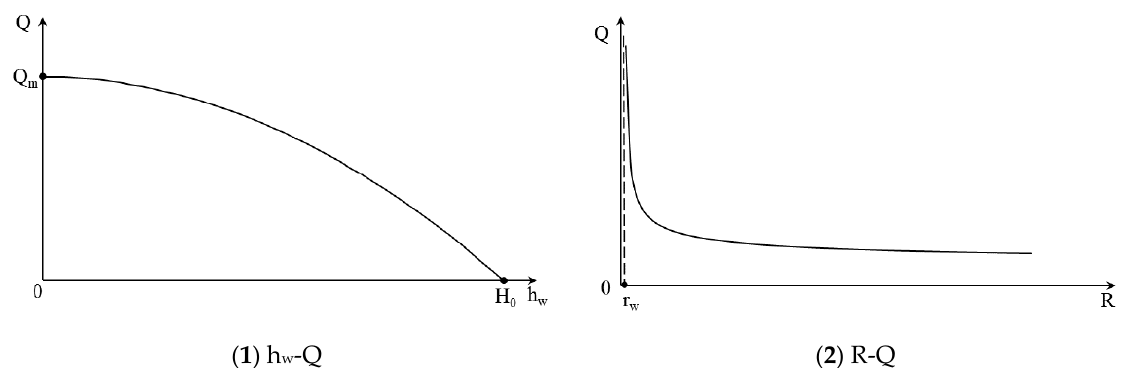
Figure 2. Relationship between the water yield of the pumping well and water level of the pumping well, and between the water yield of the pumping well and the influence radius in the Dupuit model. Q is the water yield of the pumping well, [L 3 T − 1 ]; Q m is the maximum water yield of the pumping well, [L 3 T − 1 ]; H 0 is the thickness of the aquifer, [L]; h w is the water level of the pumping well, [L]; r w is the radius of the pumping well, [L]; and R is the influence radius, [L].